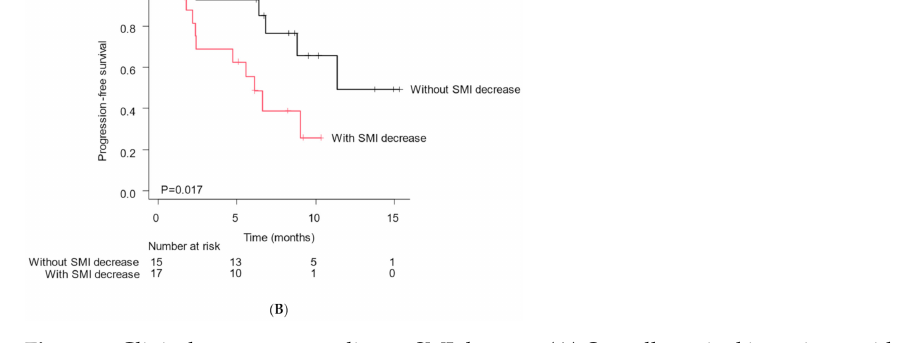
Figure 3. Clinical outcome according to SMI decrease ( A ) Overall survival in patients with or without an SMI decrease. ( B ) Progression-free survival in patients with or without SMI decrease. Table 3. Radiological